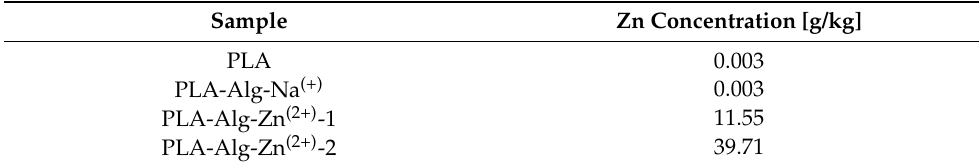
Table 5. Zinc concentration in PLA-Alg-Zn (2+) samples.